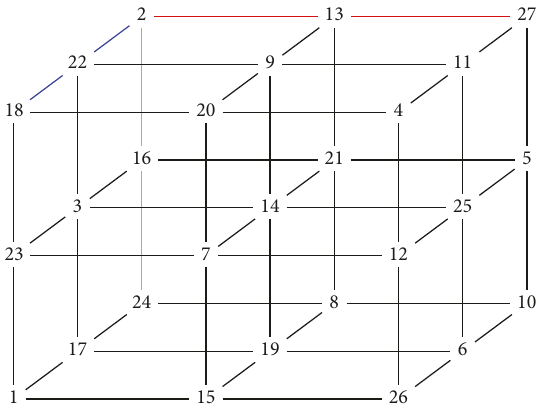
Figure 2: An example of magic cubes of order